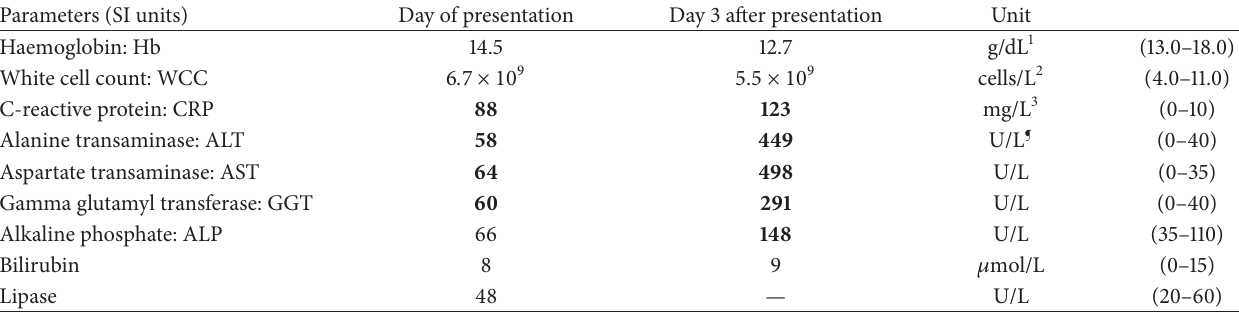
Table 1: Biochemistry and haematology results.